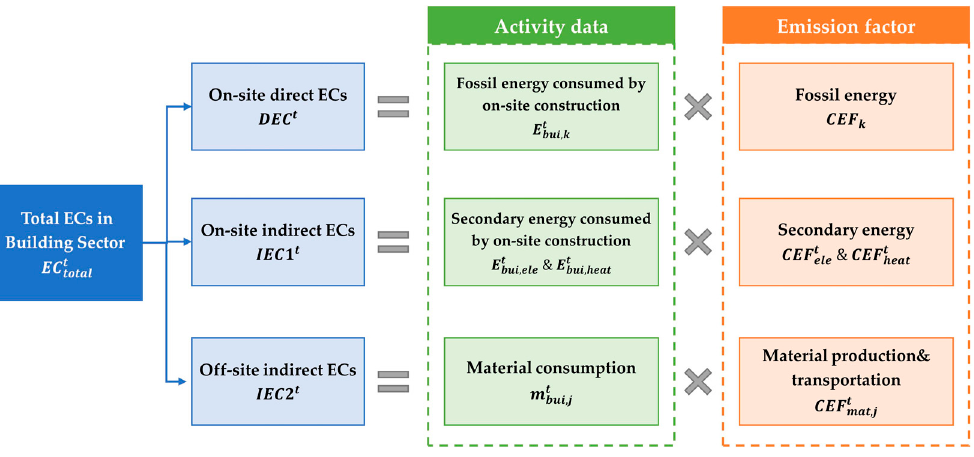
Figure 5. The framework of the P-LCA accounting model.